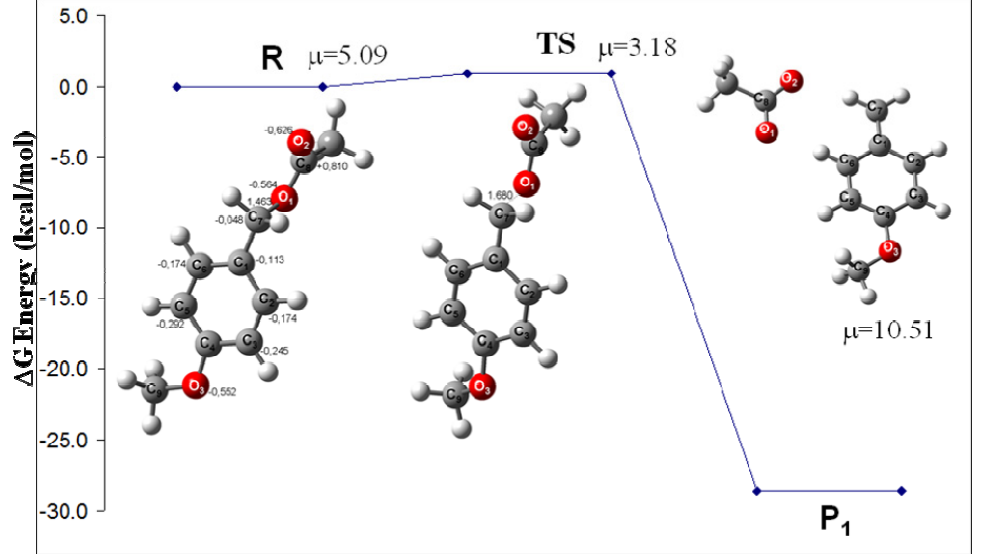
Figure 1. B3LYP/6-311++G(d,p) energy profile for the carbenium ion